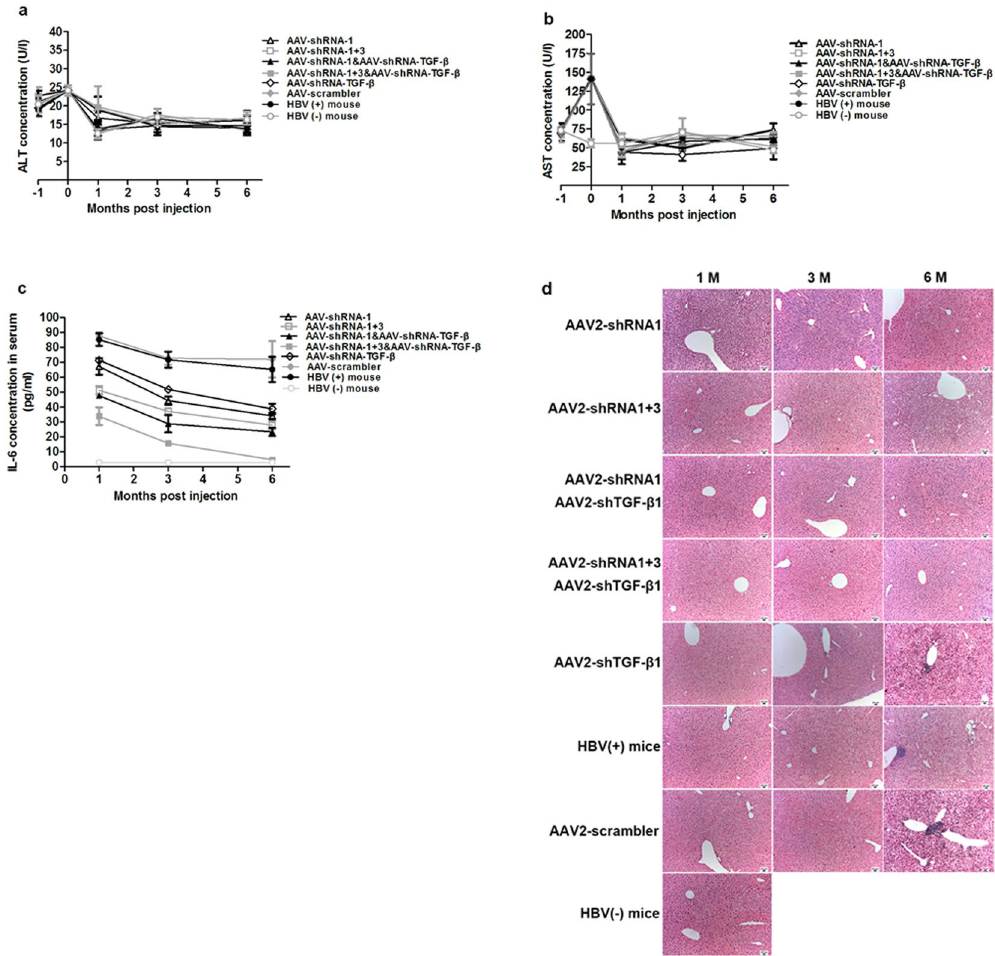
Figure 6. AAV-shRNA treatment improves liver tissue histology without inducing acute inflammation. Mice received AAV2-shRNA treatment, and serum and liver samples were collected at the indicated time points during a 6 month period. ( a–c ) Time-course changes of serum levels of ALT ( a ), AST ( b ), and IL-6 ( c ). ( d ) Liver sections stained with hematoxylin and eosin. Data represent the mean ±